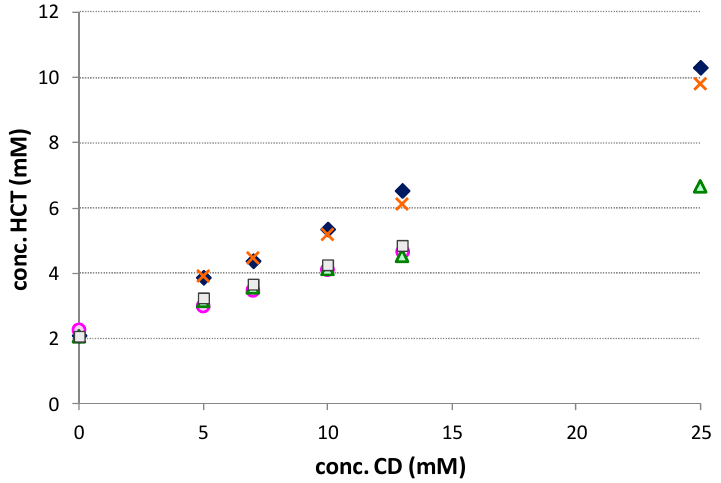
), SBE β CD (X), (cid:35)